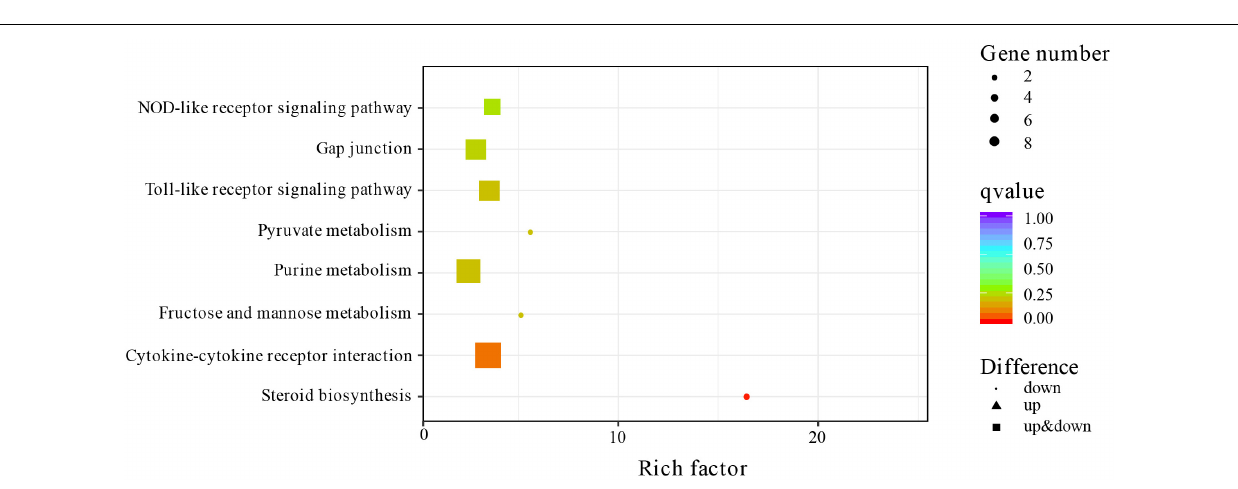
FIGURE 2 | Bar plot of the Gene Ontology (GO) categories of the differentially expressed genes (DEGs). (A) Biological process. (B) Cellular component. (C) Molecular function.